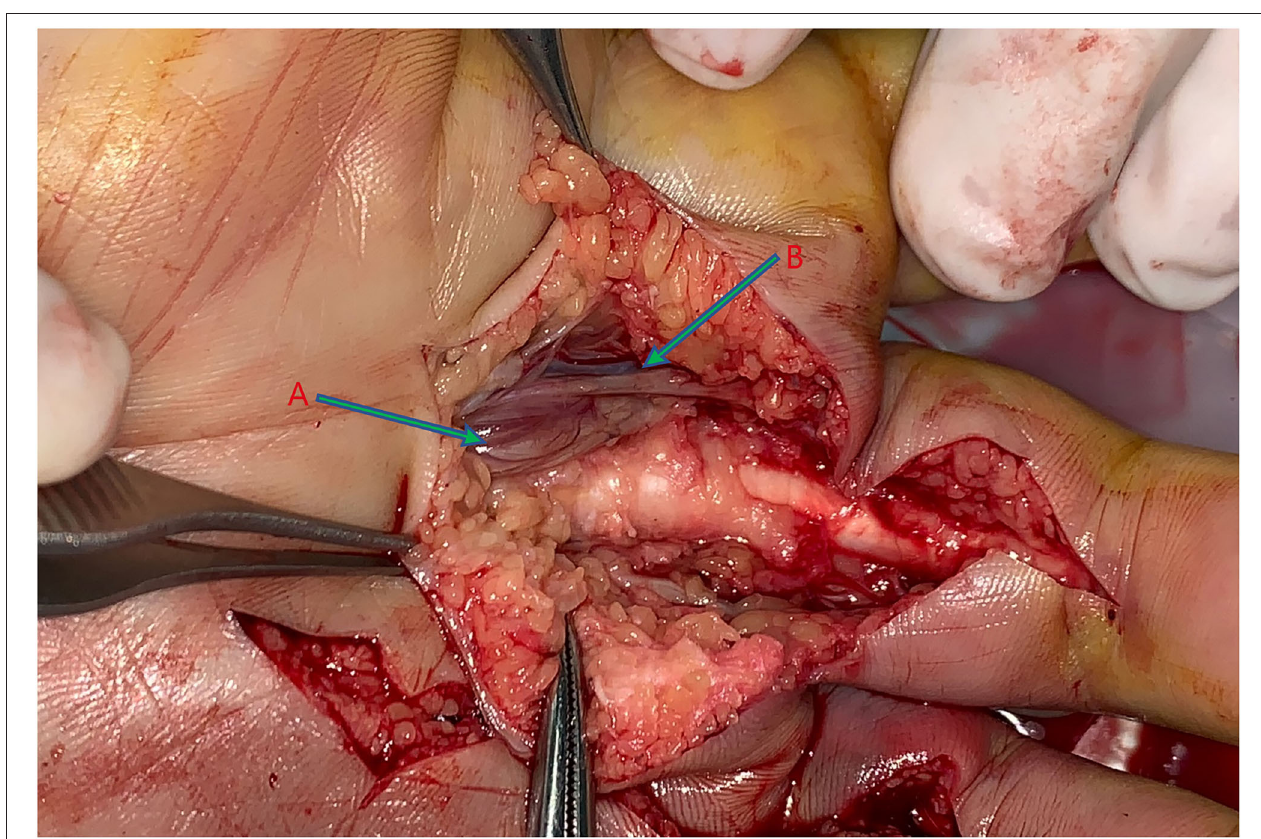
FIGURE 3 | Debridement on the palm side: (A) Pallor intrinsic muscles with the pathological report: a small piece of skeletal muscle tissue with purulent inflammation and a small amount of necrosis. (B) Neurovascular bundle.